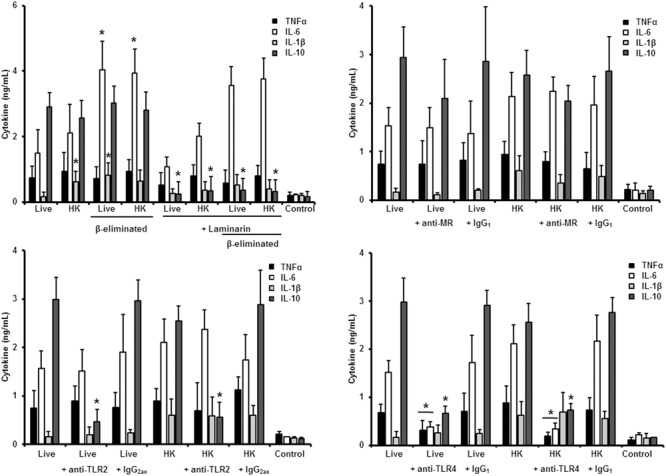
Cytokine production by human PBMCs stimulated with S. brasiliensis conidia. Human PBMCs were co-incubated 24 h with either live, HK, live and β-eliminated, or HK and β-eliminated conidia, supernatant collected and used to quantify the cytokine levels. Alternatively, human PMBCs were pre-incubated with laminarin, anti-MR, anti-TLR2, or anti-TLR4 antibodies before interaction with fungal cells. Irrelevant, isotype-matching antibodies were used as controls, as indicated. ∗P < 0.05, when compared with untreated cells.